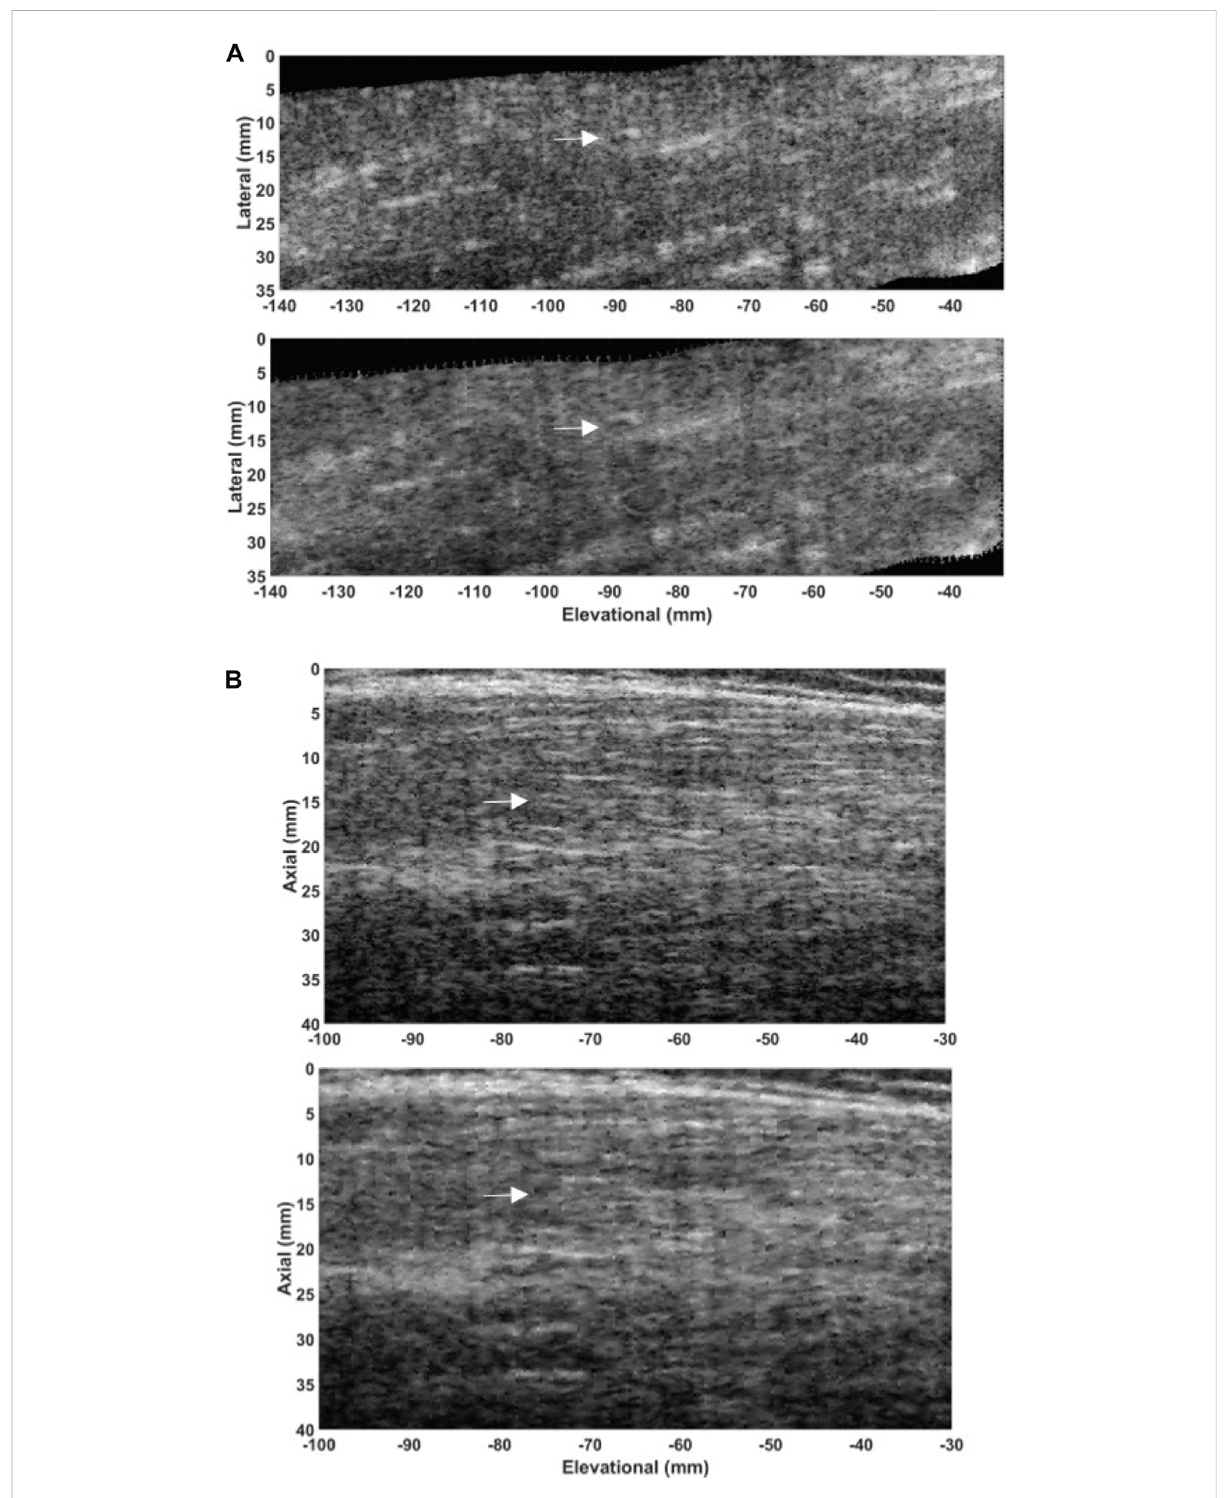
FIGURE 10 In-vivo 3DUSdataofatibialisanterioracquiredwithlongitudinalsweep. (A)